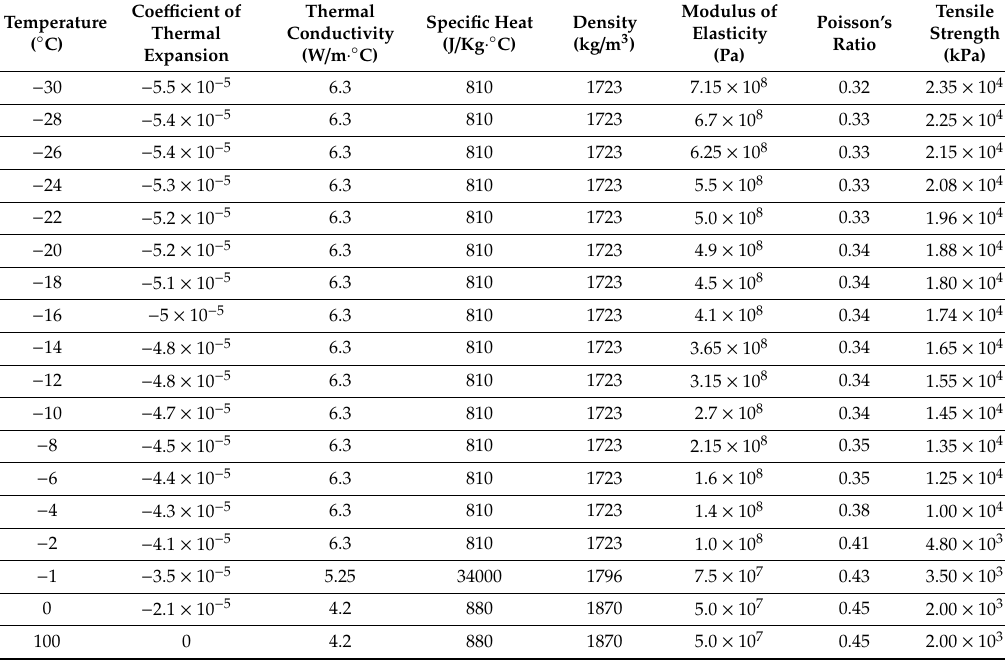
Table 2. Thermal physical and mechanical parameters of the